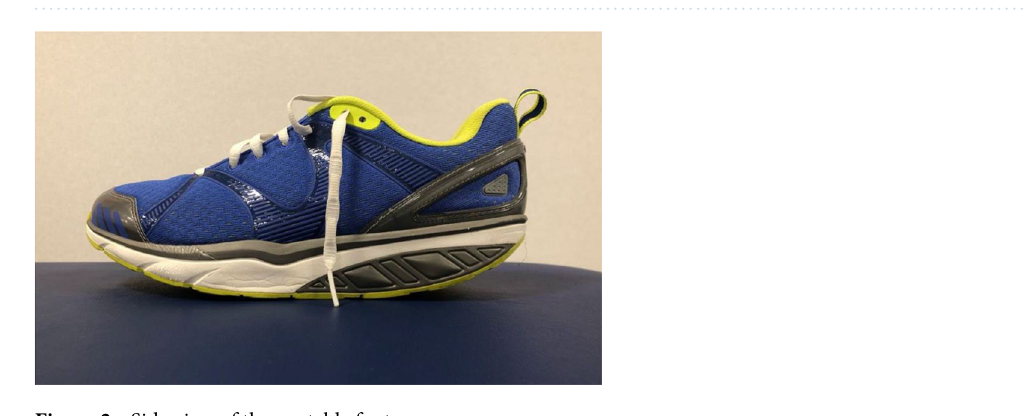
Figure 1. Vibratory platform positions—( a ) X-axis bipodal; ( b ) Y-axis bipodal; ( c ) X-axis monopodal right leg; ( d ) X-axis monopodal left leg.